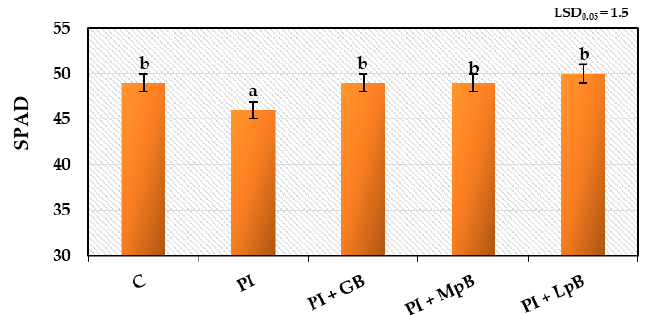
Figure 7. Index of chlorophyll content in leaves obtained from Impresja seed potatoes treated with biopreparations and inoculated with phytopathogens. C—control potato, not treated with any biopreparations and not inoculated with pathogens; PI—potato sample only inoculated with pathogens; PI + GB—potato sample treated with aqueous garlic extract biopreparation and inoculated with pathogens; PI + MpB—potato sample treated with M. pulcherrima TK1 biopreparation and inoculated with pathogens; PI + LpB—potato sample treated with L. plantarum KB2 LAB 03 biopreparation and inoculated with pathogens. Means marked with the same letters (a,b) do not differ statistically at the significance level p = 0.05; LSD—least significant difference.